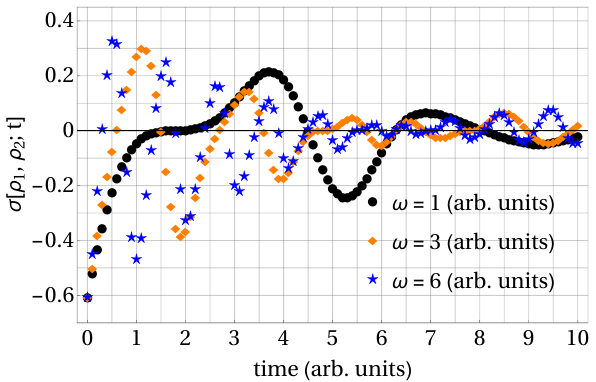
Figure 13. Information flow, σ ( ρ 1 , ρ 2 ; t ) , for three values of ω